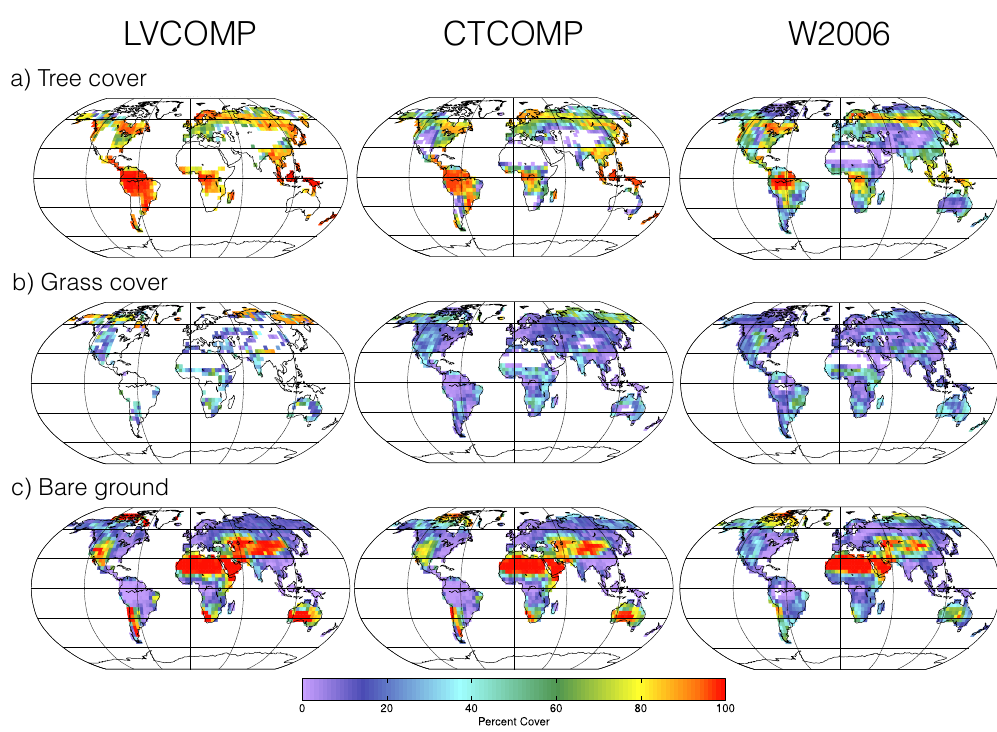
Figure 2. Global tree (a) , grass (b) , and bare ground (c) cover at equilibrium for pre-industrial conditions as simulated by CTEM using the unmodified L–V relations (LVCOMP; left column), the CTEM competition scheme with modified L–V relations (CTCOMP; middle column), and the observation-based fractions from the modified Wang et al. (2006) data set (W2006; right